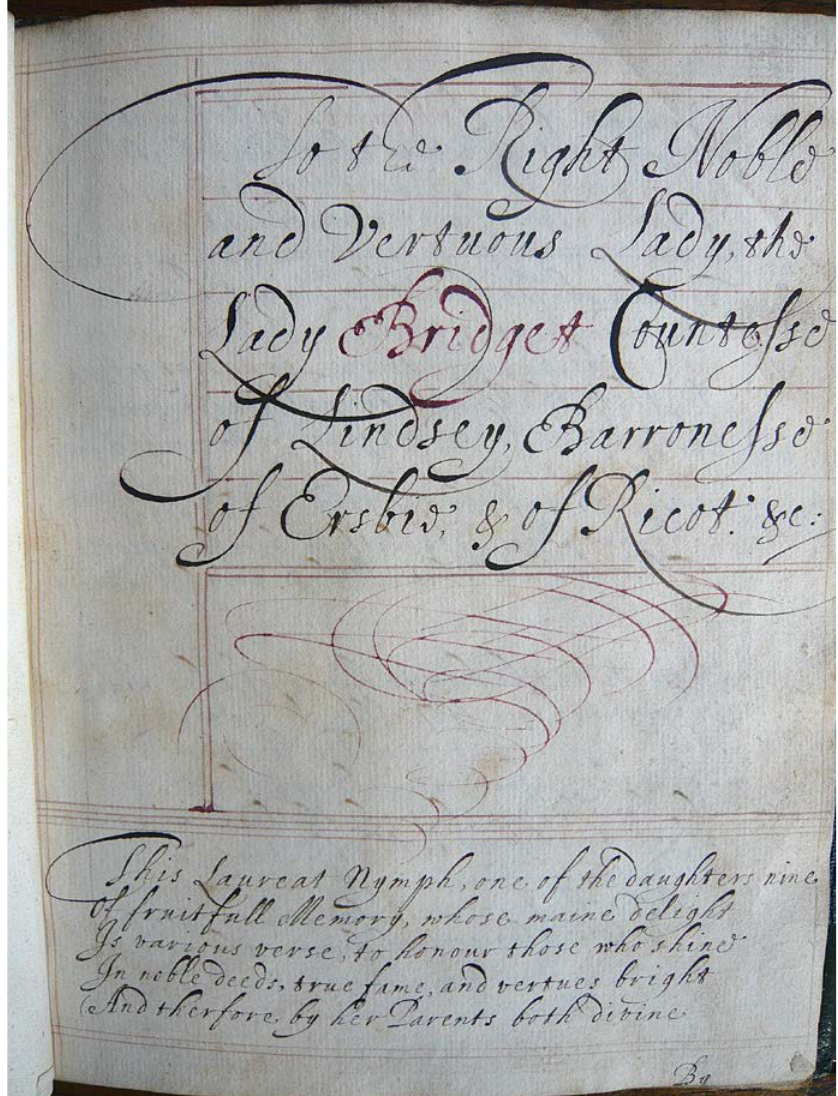
Fig. 2 - Title of the collection’s opening poem to Bridget Bertie, countess of Lindsey, f.